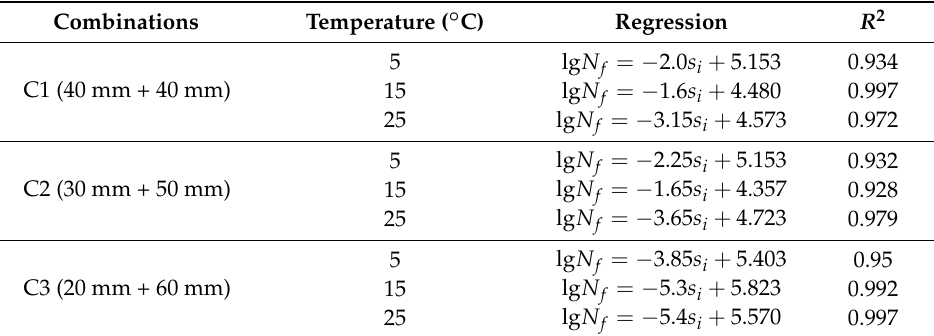
Table 9. Stress ratio level—fatigue life regression equation of each combination.